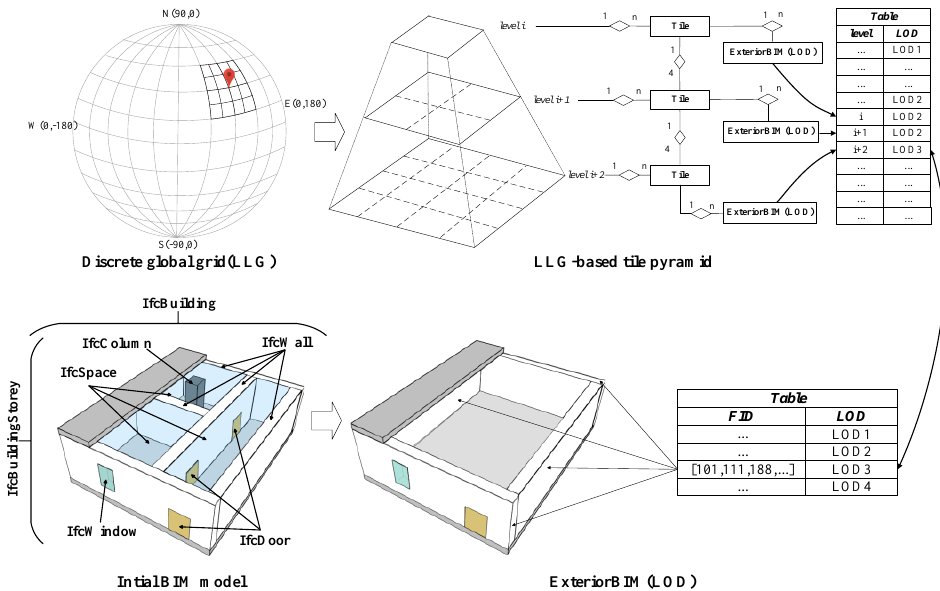
Figure 3. Data organization for large-scale Building Information Modeling (BIM) models in outdoor scenes.